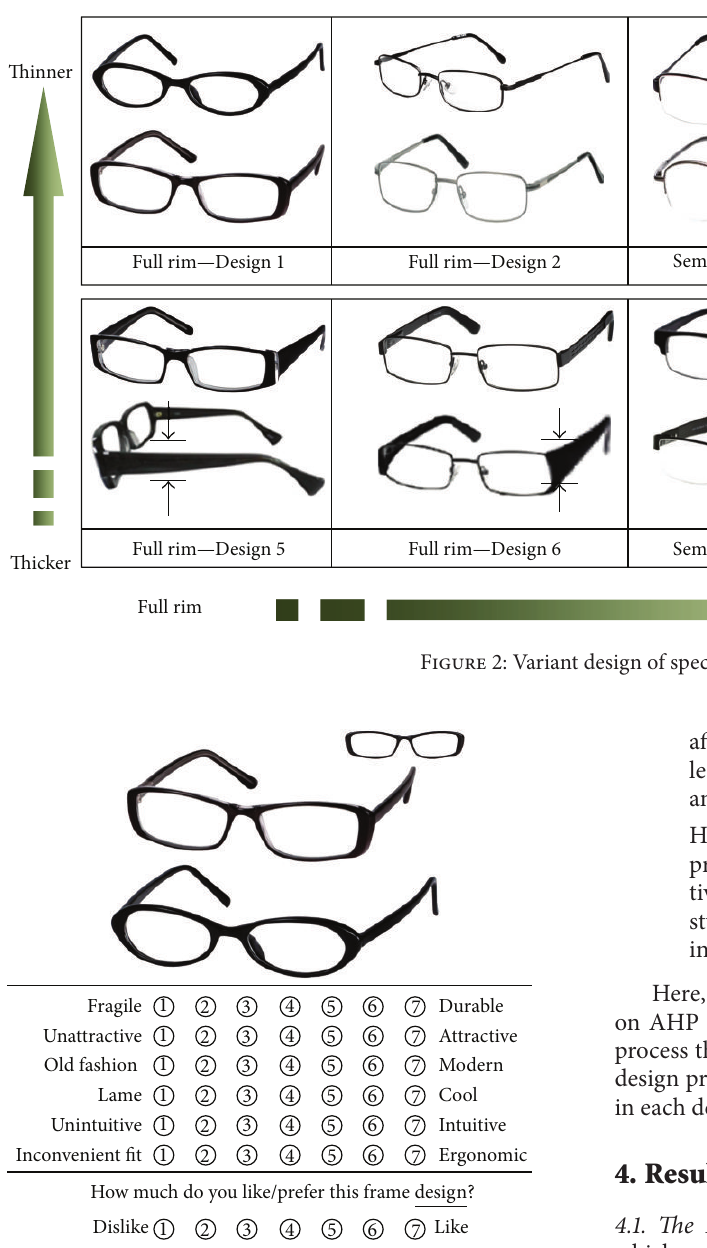
Figure 3: Kansei words and design preferences